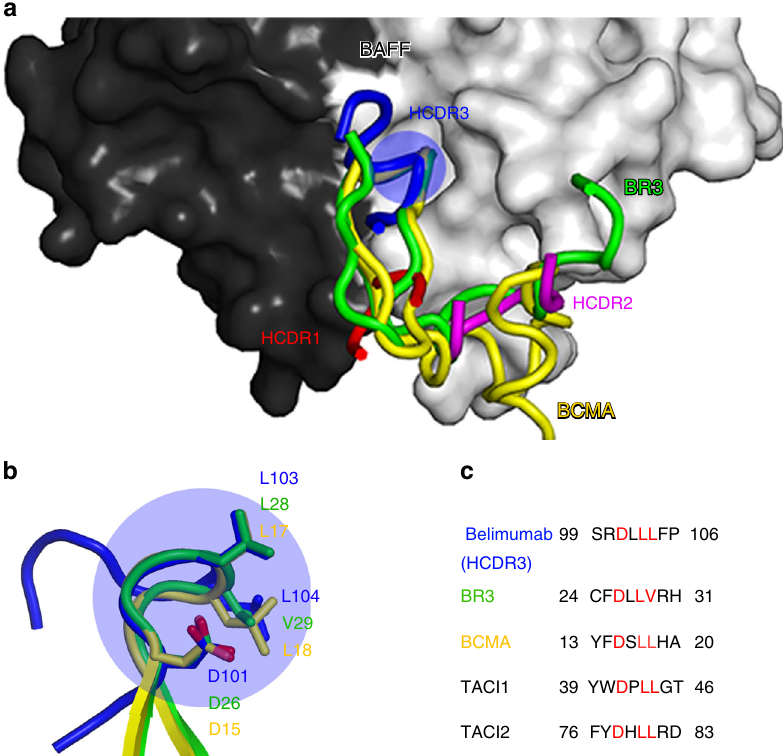
Fig. 6 Similarity between belimumab HCDR3 and the DxL(V/L) motif. a Comparison of BAFF binding among BR3, BCMA, and the belimumab HCDR loops at the BAFF surface (black and gray for each protomer). b The conformations of the DxL(V/L) motifs within BR3 (green), BCMA (yellow), and the belimumab HCDR3 loop (blue). The key residues in the DxL(V/L) motifs are labeled. In a and b , the DxL(V/L) motifs are indicated by blue circles. c Amino acid sequence comparison between the belimumab HCDR3 loop and the DxL(V/L) motifs of BAFF receptors. Conserved residues are colored